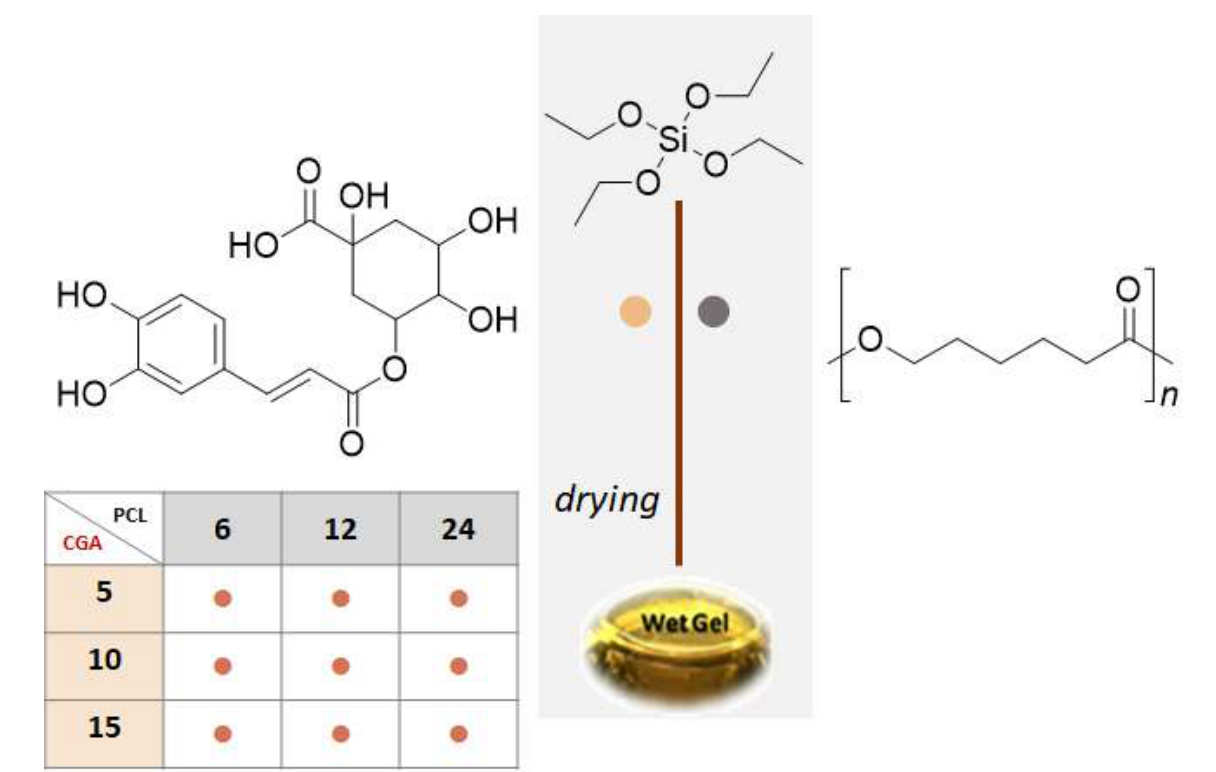
Figure 7. Flowchart of Sol–Gel Synthesis of SCxPy hybrids (●). (●) refers to CGA; (●) refers to PCL.